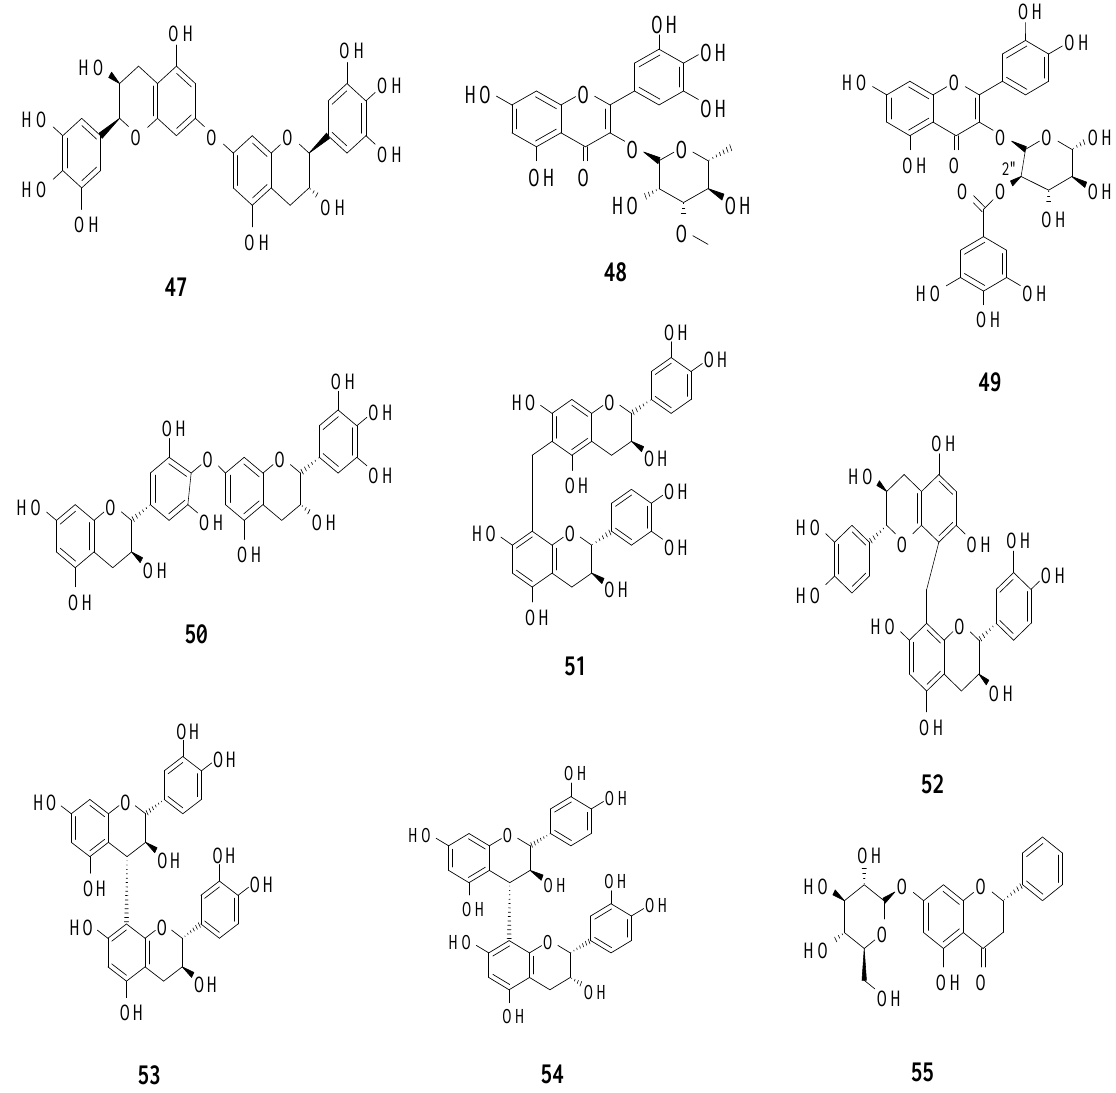
glucose moiety and 1 (82.47 and 75.80 μM). The presence of a hydroxyl group in the B- the B-ring was discovered to be essential, as evidenced by compound 55 (cid:48) s weak inhibition ring was discovered to be essential, as evidenced by compound 5 5′ s weak inhibition (IC 50 (IC 50 = 155.57 µ M). = 155.57 μM).